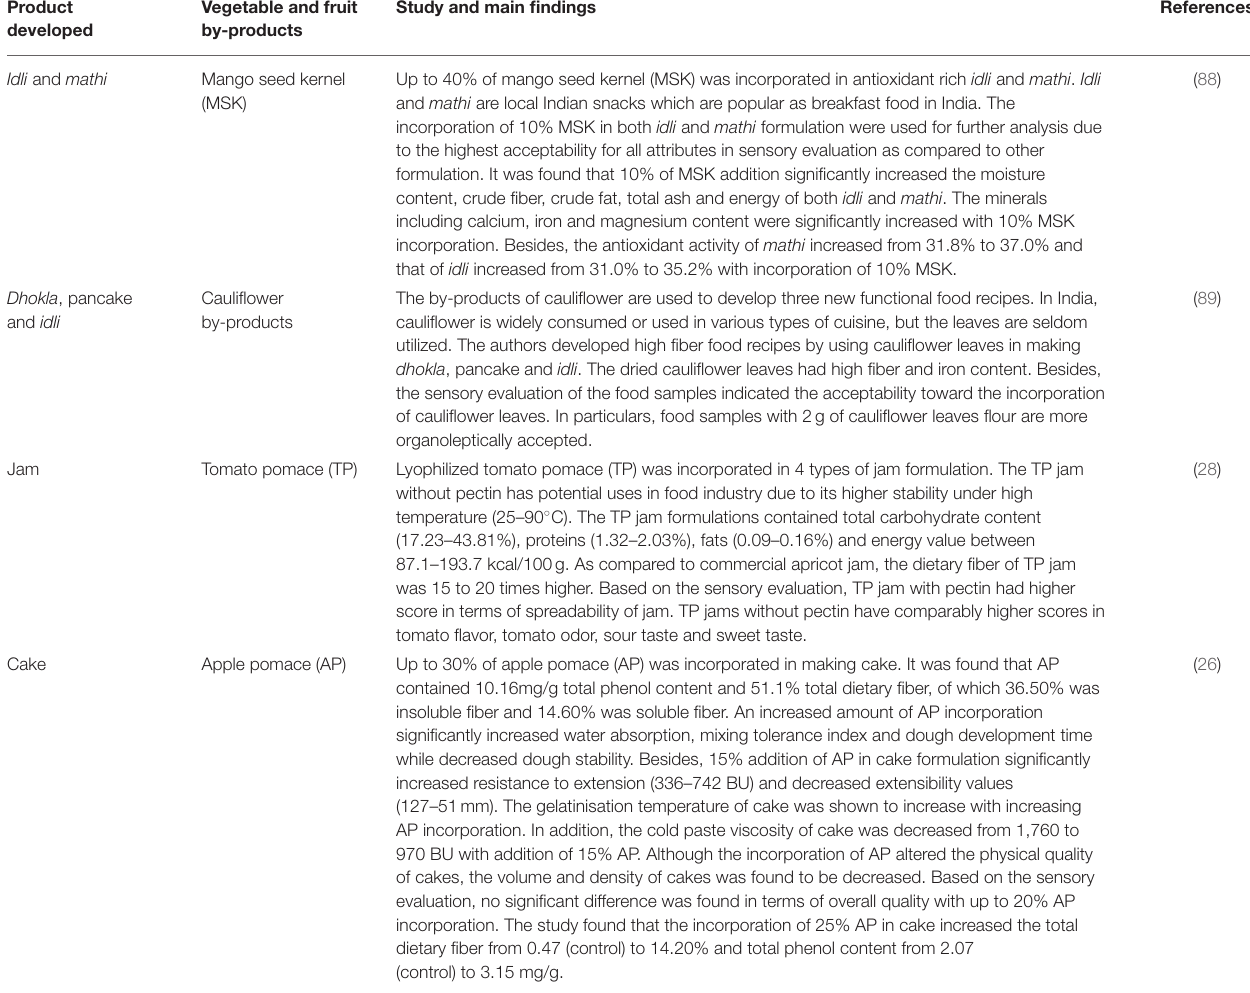
TABLE 5 | Study and main findings of vegetable and fruit by-products utilization as functional ingredients in development of other products. Product